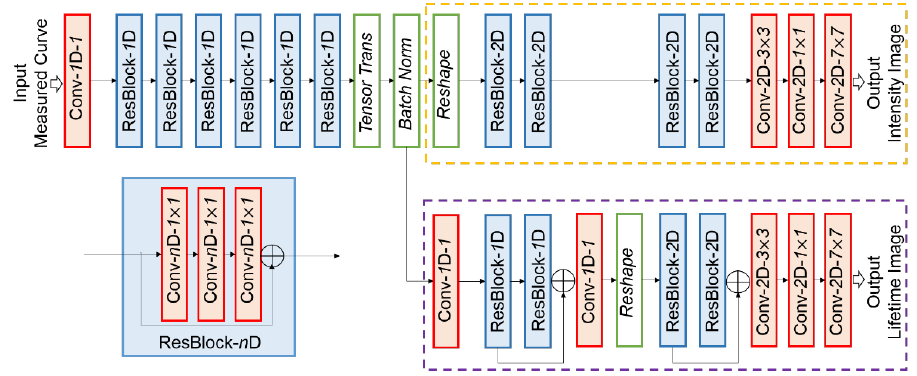
Fig. 3. Architecture of Net-FLICS. 63 The upper section includes the shared convolutional segment and intensity image recon- struction branch (inside the orange dotted rectangle), while the lower section includes the lifetime image reconstruction branch (inside the purple dotted rectangle). The detail of nD ( n ¼ 1, 2) residual block is shown at the left bottom,